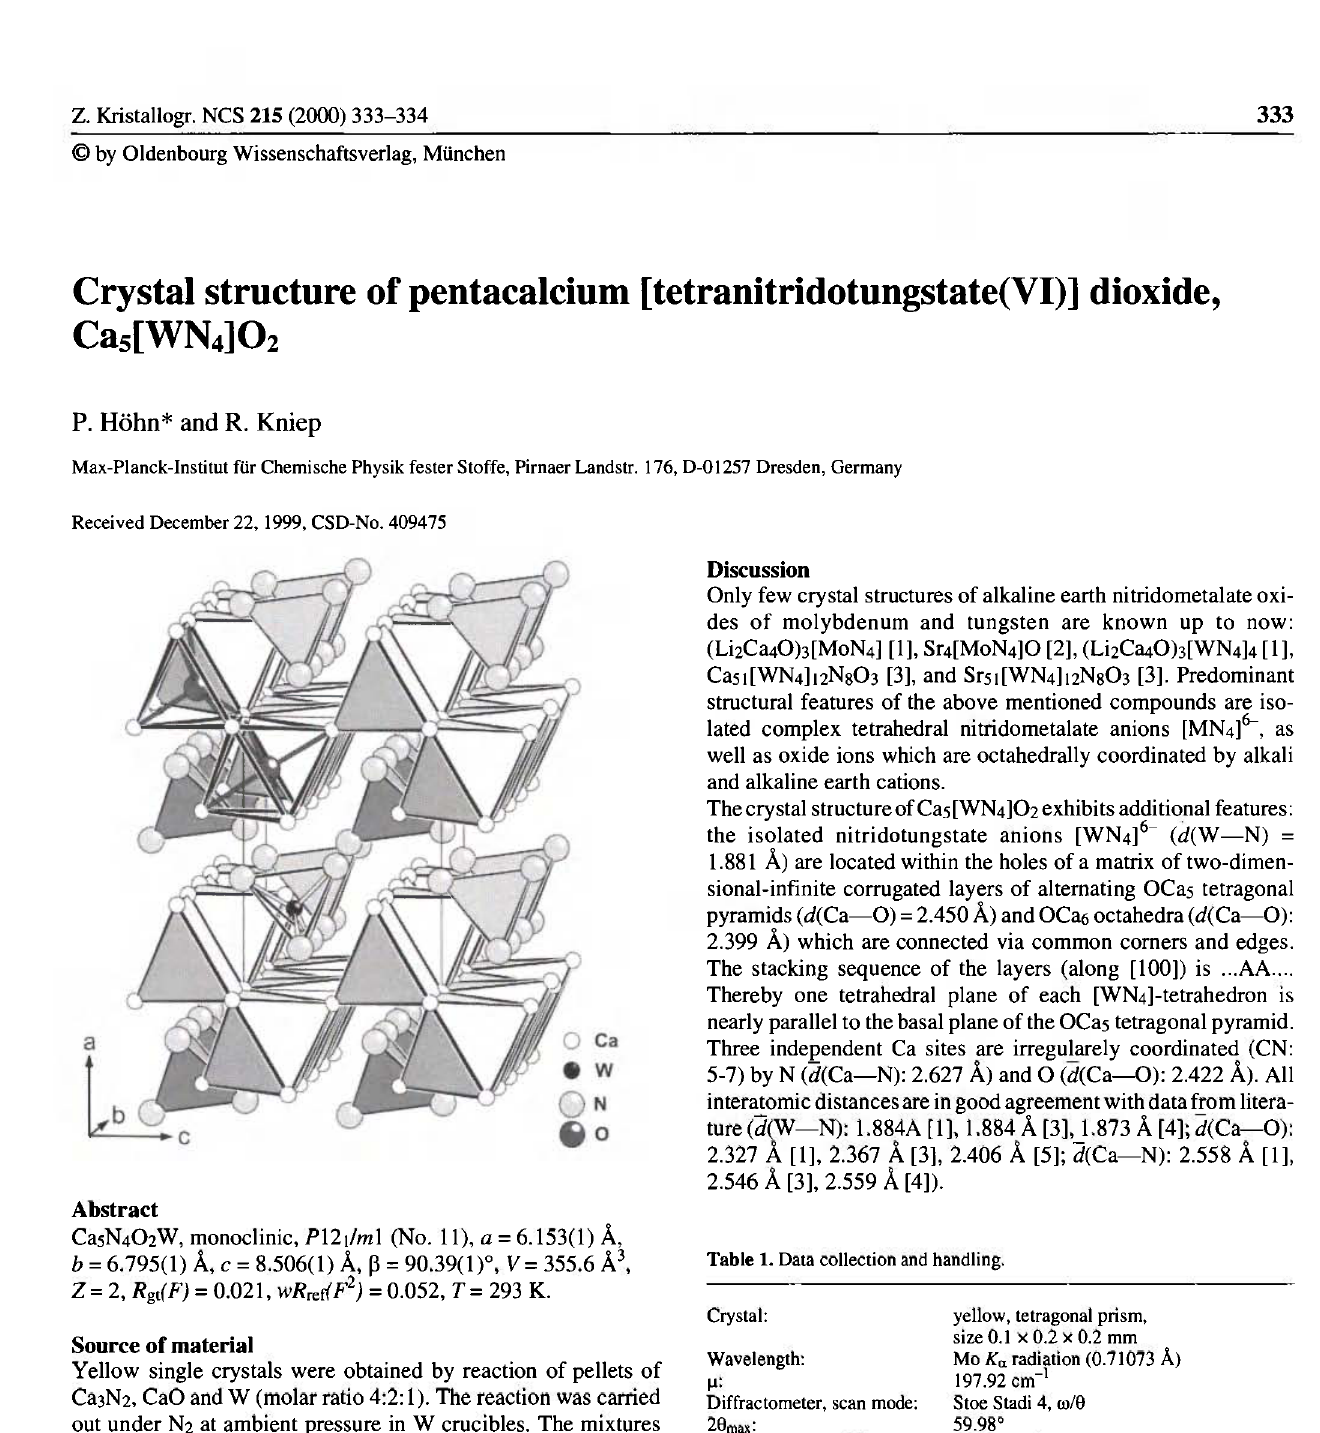
Source of material Yellow single crystals were obtained by reaction of pellets of Ca3N2, CaO and W (molar ratio 4:2:1). The reaction was carried out under N2 at ambient pressure in W crucibles. The mixtures were heated to 1223 Κ (100 K/h). After a period of 36 h the products were cooled down (50 K/h) to ambient temperature. Starting materials and products are sensitive to moisture and air.